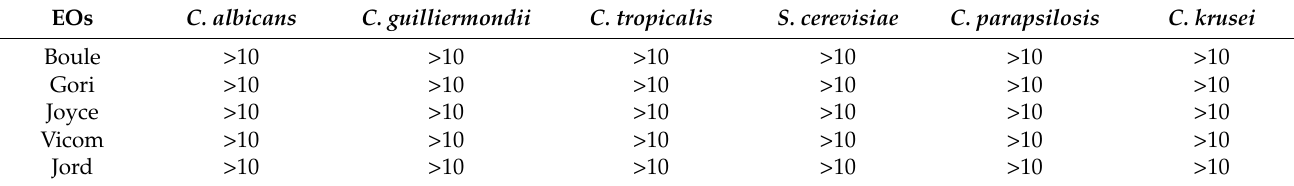
Table 5. Antimycotic activity MIC values (% v / v ) of the selected EOs against the yeast strains. EOs C.